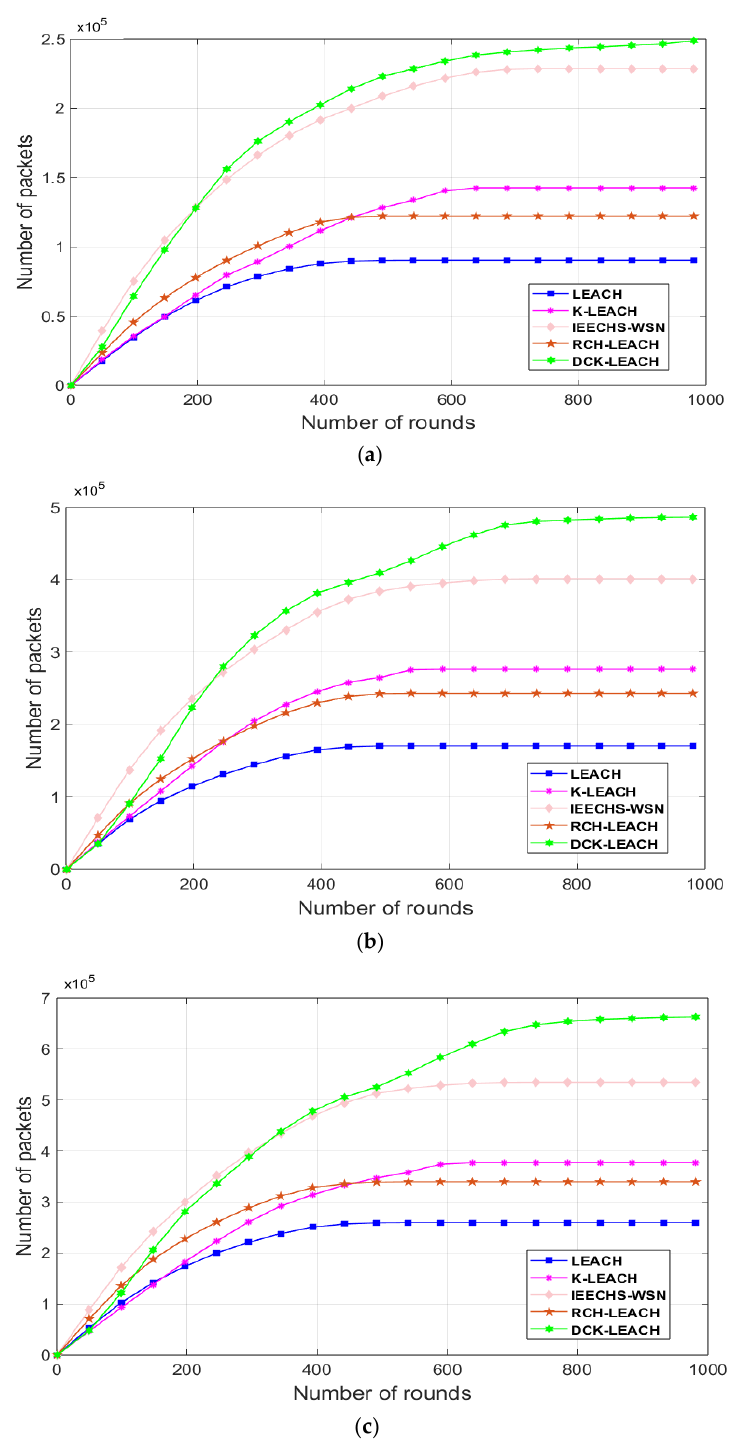
Figure 7. Comparison throughput of the network in three scenarios: ( a ) 100 nodes, ( b ) 200 nodes, ( c ) 300 nodes.